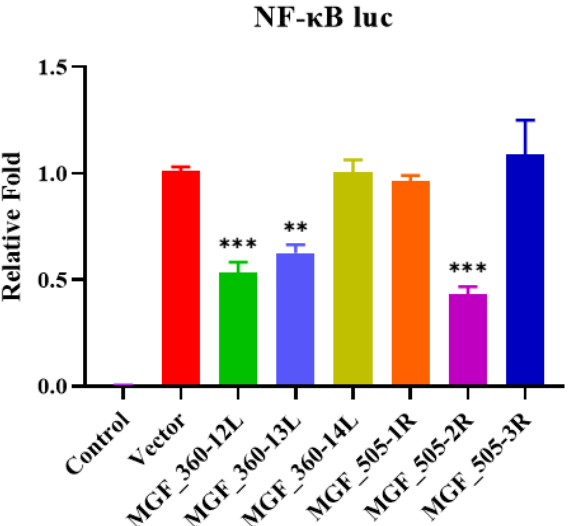
Figure 5. MGF360-12L, MGF360-13L, and MGF505-2R interfere with the NF- κ B signaling pathway. Plasmid encoding MGF360-12L, MGF360-13L, MGF360-14L, MGF505-1R, MGF505-2R, MGF505-3R, or empty vectors were co-transfected into PK-15 cells with the NF- κ B-Luc promoter reporter plasmid and with pRL-TK. After 24 h, luciferase activity was determined by dual-luciferase assay. Each datum represents results of three independent experiments (means ± SD). Significant differences compared with the control group are denoted by ** ( p < 0.01) and *** ( p < 0.001).